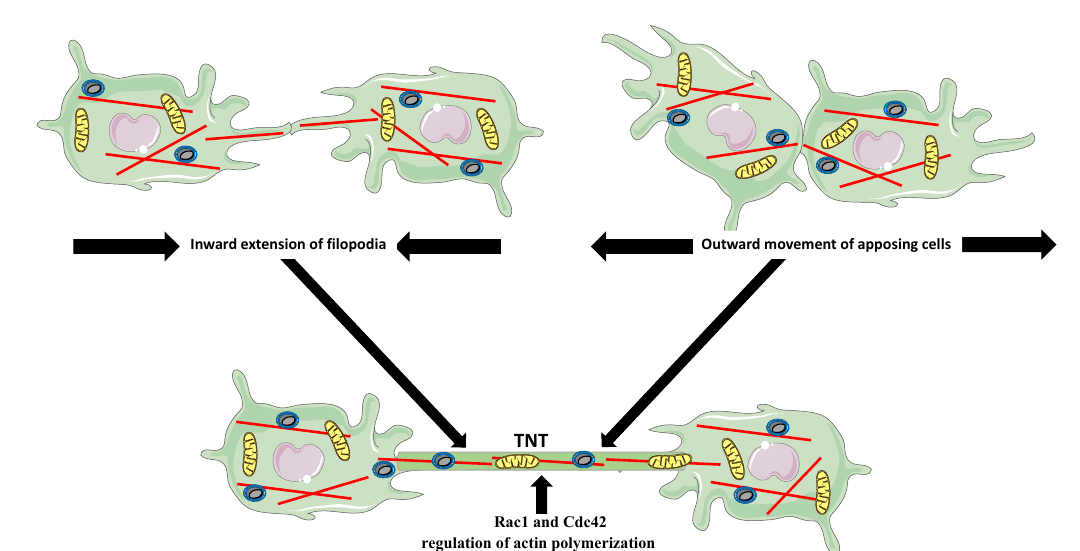
Figure 2. Two modes of tunneling nanotubes (TNTs) formation. The distant cells extend filopodia, which fuse and elongate to form the TNT ( upper left panel ). The closely apposing cells attach and move outward extending the membrane connection into a TNT ( upper right panel ). The bottom panel shows two cells connected by TNT, which transports organelles, such as mitochondria and vesicles, between cells.